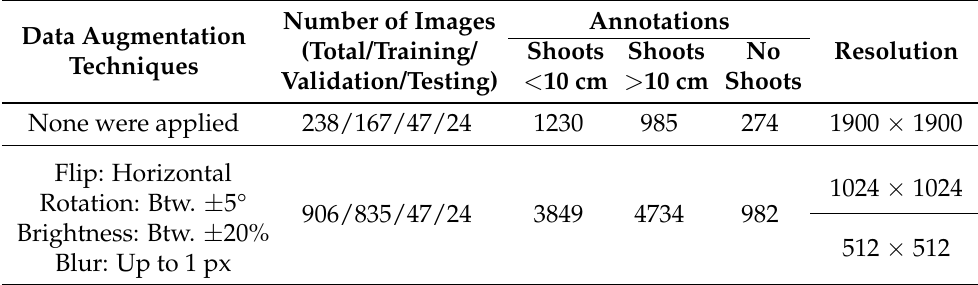
Table 1. Grapevine’ shoots initial dataset versions.